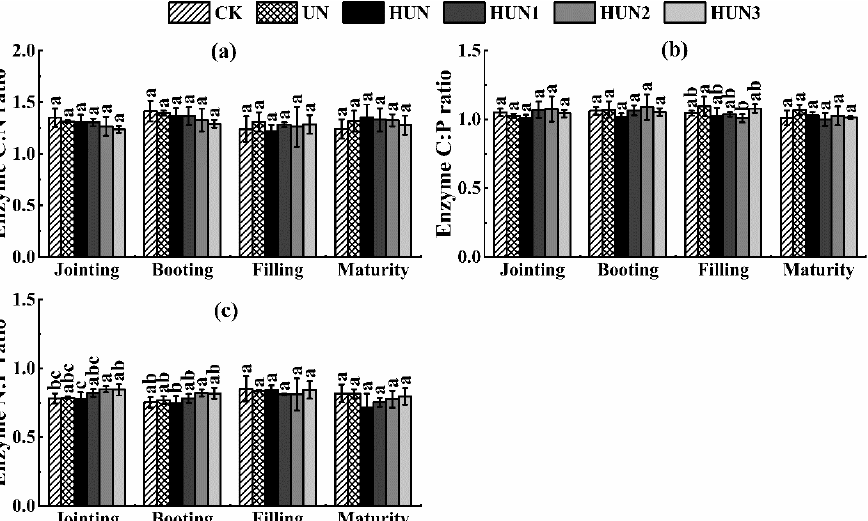
Figure 7. Effects of different treatments on enzyme C:N ratio ( a ), enzyme C:P ratio ( b ) and enzyme N:P ratio ( c ) in wheat growth stages. The lengths of the bars are average values. The length of the error bars is the standard deviation. Different letters indicate significant differences between different treatments at p < 0.05 for the same wheat growth stages. C: carbon. N: nitrogen. P: phosphorus. CK: no nitrogen. UN: urea, 240 kg N hm − 2 . HUN: humic acid urea, 240 kg N hm − 2 . HUN1: humic